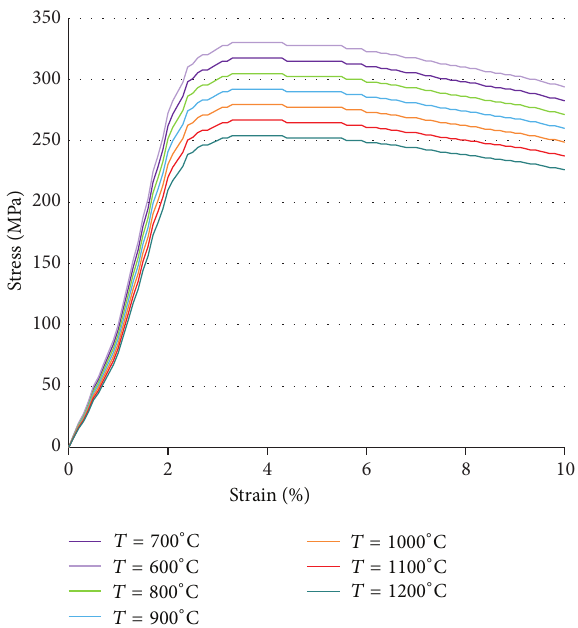
Figure 3: Plasticity curves of 9Cr-MECTUB model.